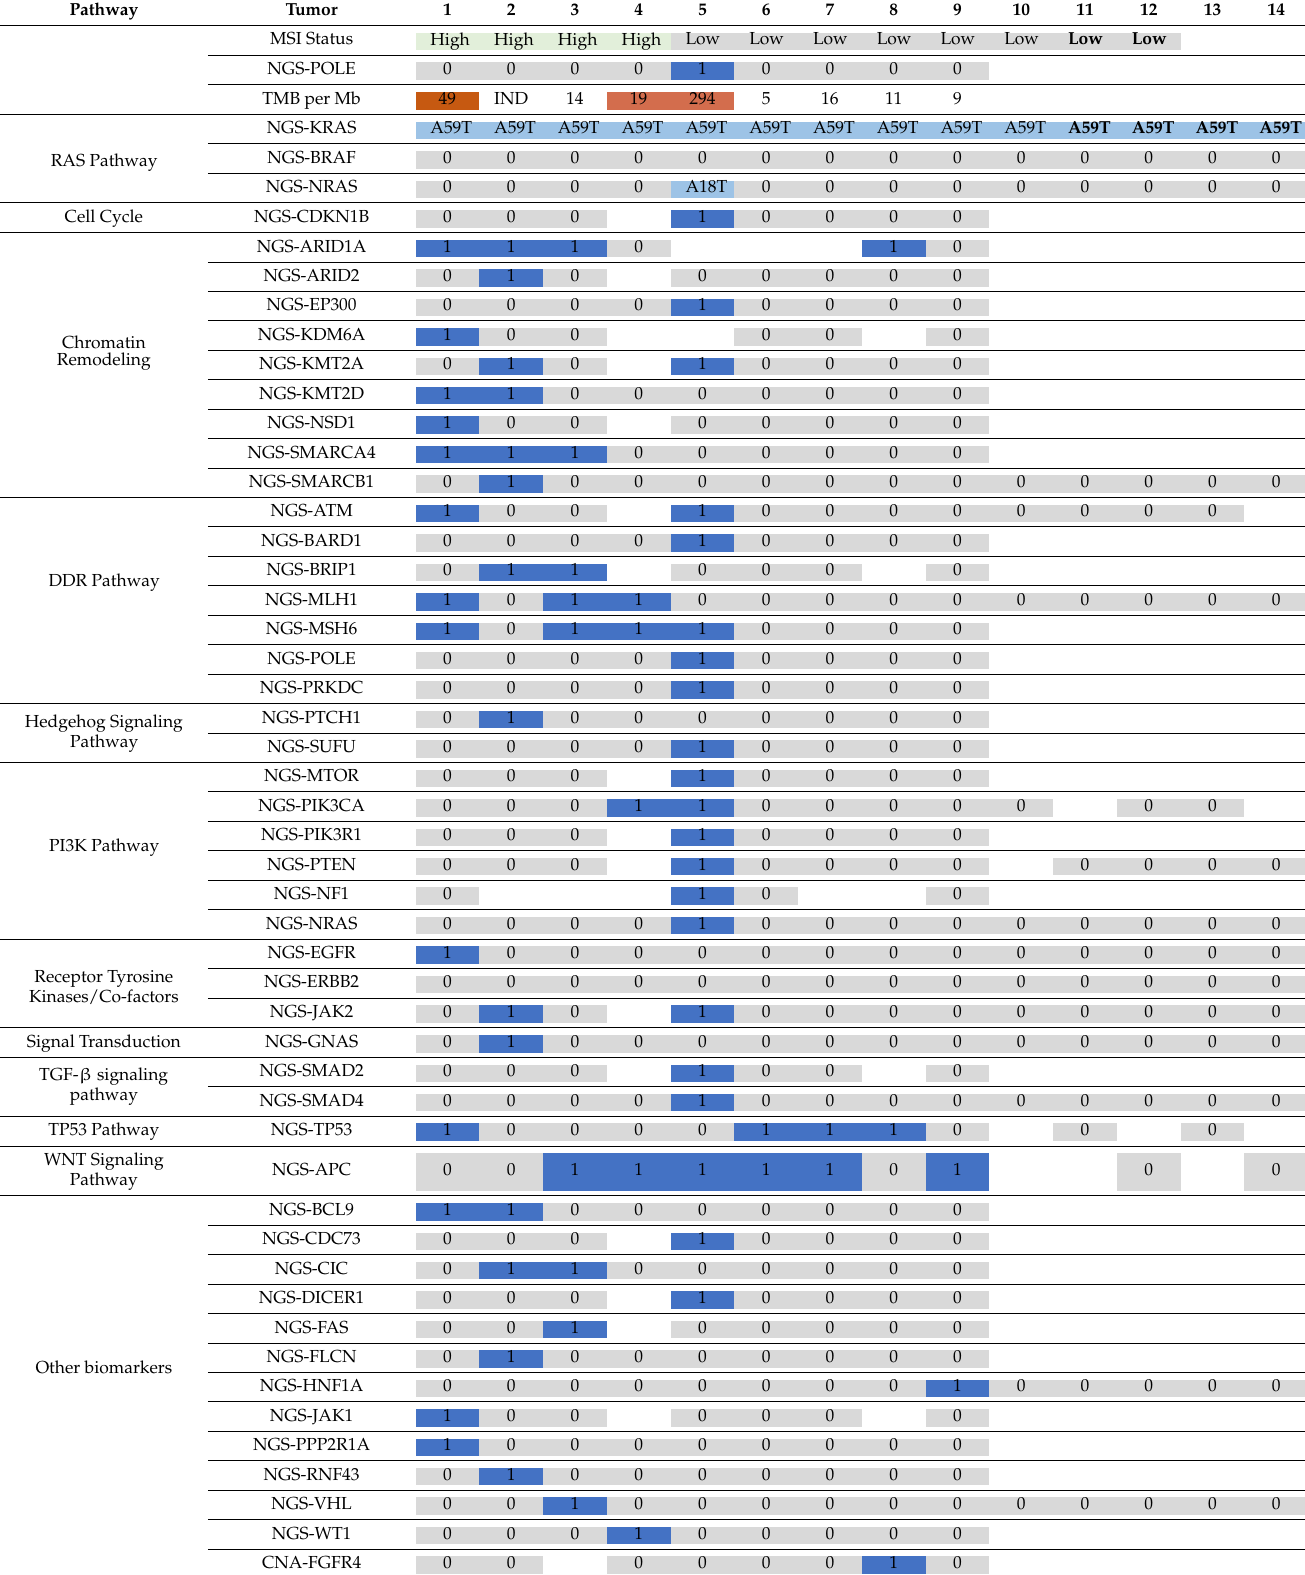
Table 4. List of mutations sorted for each of the 14 KRAS A59T CRC cases in our